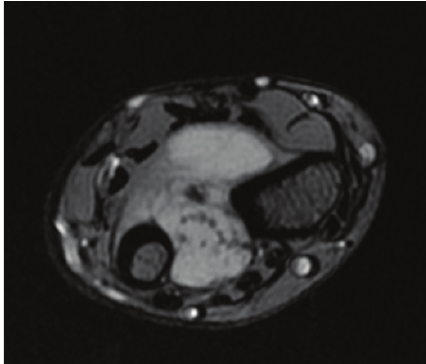
Figure 2: MRI of the left distal radioulnar joint showing calcified nodules consistent with synovial